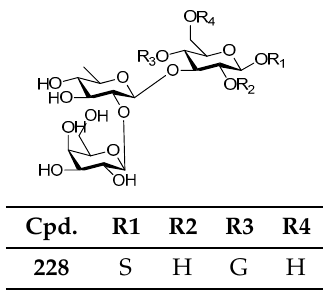
Figure 41. Structure of compound 228 .